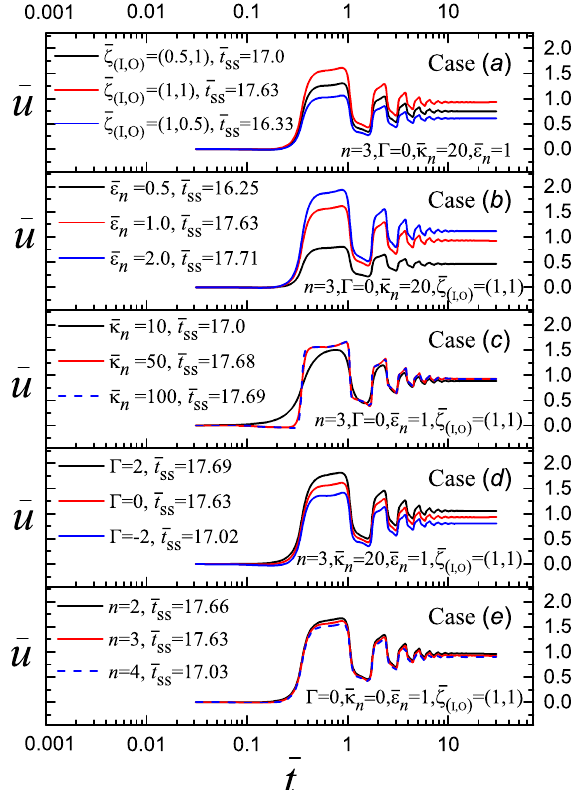
Figure 12. Velocity tracking of an electro-osmotic flow with a = 0.3, ∆ ¯ ψ n = 0.25, and ¯ λ n = ¯ η n = ¯ ρ n = 1.0 for different values of Case ( a ) ¯ ζ I,O , Case ( b ) ¯ (cid:101) n , Case ( c ) ¯ κ n , Case ( d ) Γ and Case ( e ) n , at the middle of the